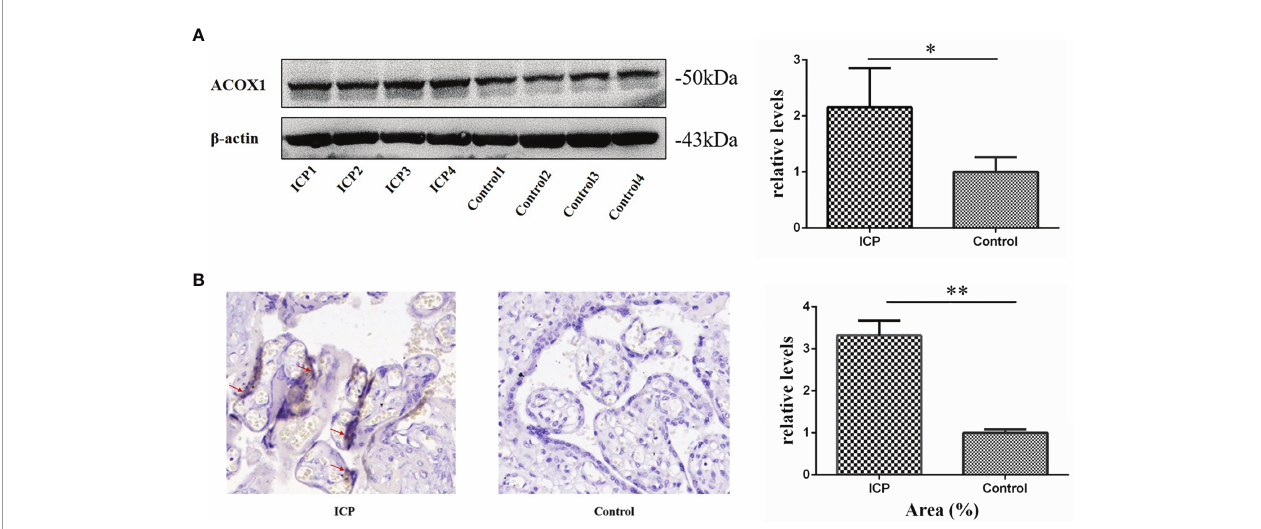
FIGURE 2 | Validation of ACOX1 protein in placental tissue. (A) Western blot analysis of placental ACOX1 in tissue obtained from pregnant women with ICP and healthy pregnant women. Placental ACOX1 levels were signi fi cantly increased among pregnant women with ICP as compared to healthy pregnant women (P=0.015); b -actin was used as an internal control. (*P < 0.05); (B) Immunohistochemical staining for placental ACOX1 among 4 pregnant women with ICP and 4 healthy pregnant women (×400). Immunohistochemistry revealed higher cytoplasmic and nuclear levels of ACOX1 in placental trophoblasts of pregnant women with ICP as compared to healthy pregnant women. The mean positive signal intensity of placenta in ICP group was signi fi cantly higher than that in control group (**P <